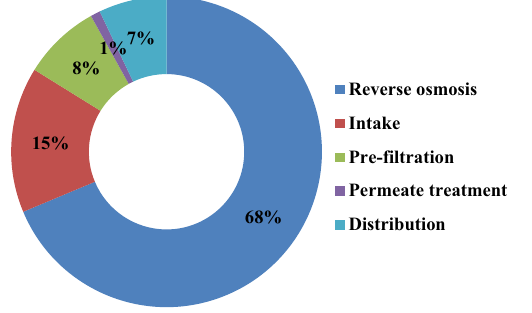
Fig. 11 The power consumption across applications or across differ- ent stages of SWRO